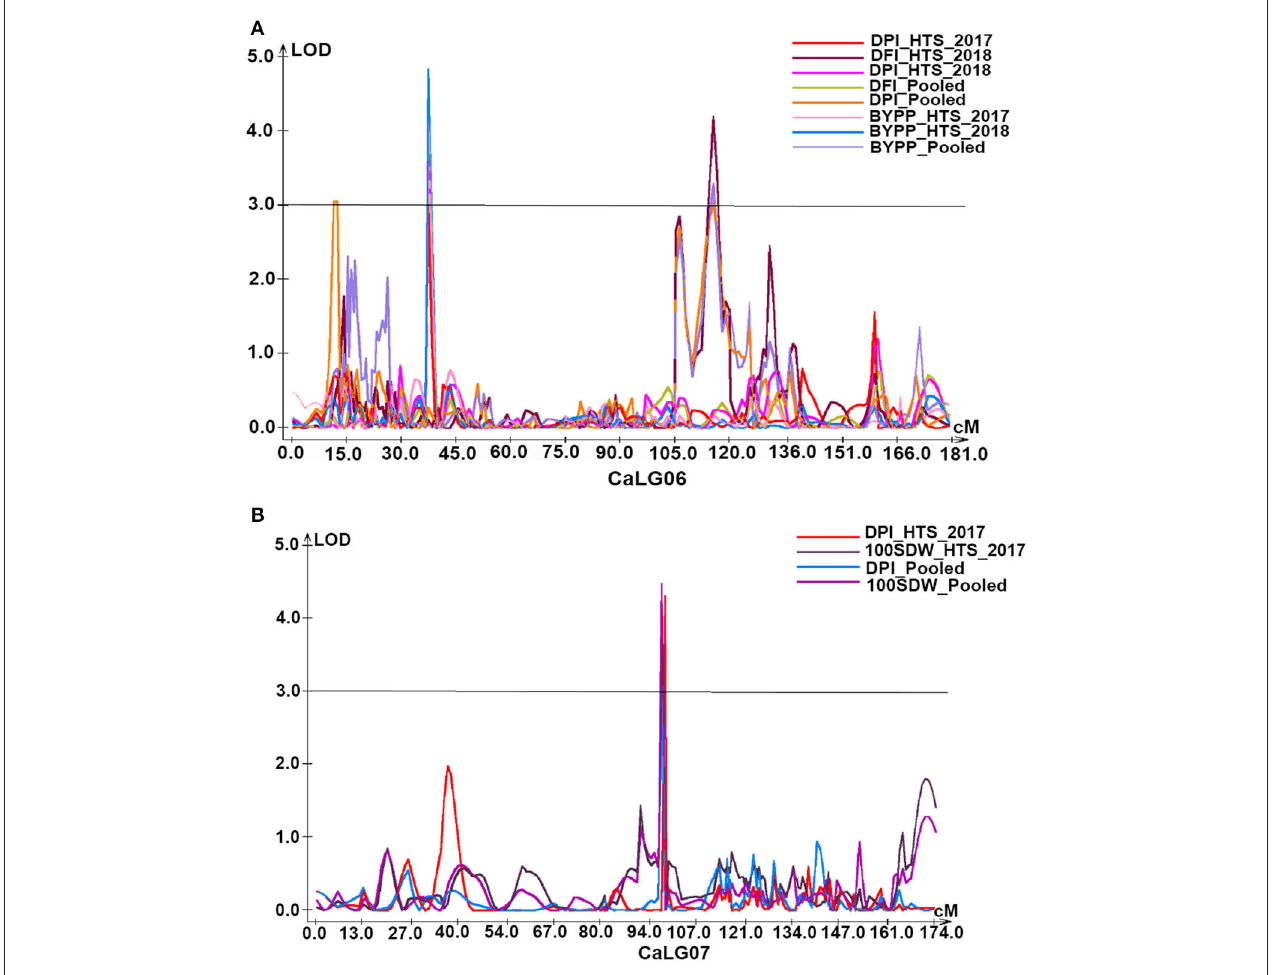
FIGURE 4 | Genomic regions with major QTLs for yield and yield-related traits. (A) Under heat stress environments of 2017–18 and 2018–19 as well as based on pooled data of these two environments QTLs for days to pod initiation (DPI, d) and biological yield per plant (BYPP, g) were mapped on CaLG06. In addition, days to flower initiation (DPI, d) of two QTLs for normalized difference vegetation index (NDVI) were identified explaining 8.84% and 9.85% PVE, respectively, on CaLG02; (B) QTLs for days to pod initiation (DPI, d) and 100 seed weight (100SDW, g) under stress environment of 2017–18 as well as based on pooled data of both heat stress environments of 2017–18 and 2018–19 were co-localized on